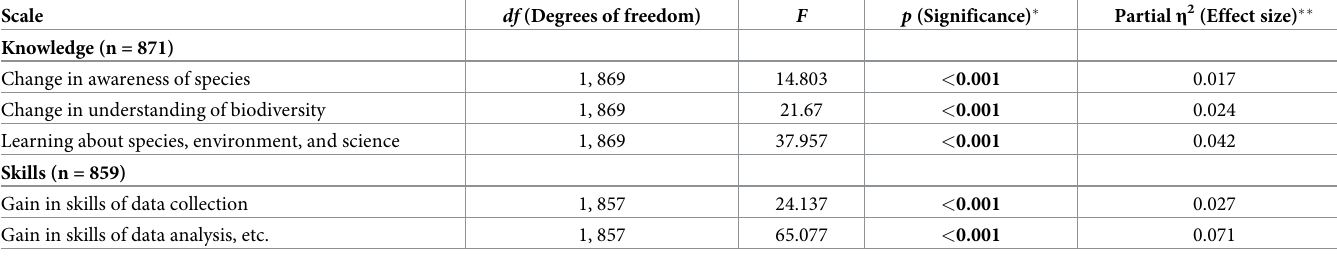
Table 7. Results of the one-way independent ANOVA test for whether participants had been in contact with other participants or not. Scale df (Degrees of freedom) F p (Significance) � Partial η 2 (Effect size)